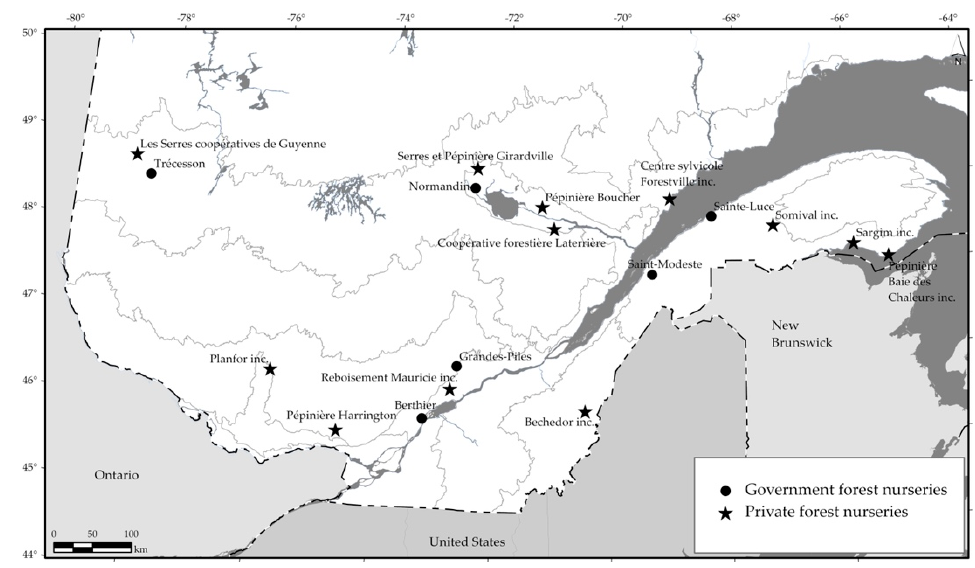
Figure 1. Locations of private and government forest nurseries in the province of Québec (adapted from Lamhamedi et al. [23]).